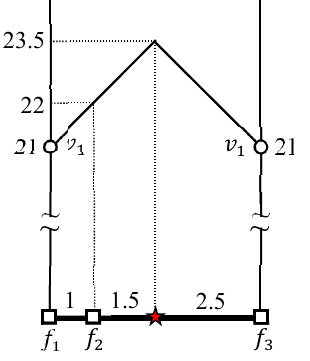
Figure 6. d max ( v 1 , f 1 f 2 f 3 ) = 23.5 and d min ( v 1 , f 1 f 2 f 3 ) = 21. Figure 6 depicts the computation of d max ( v 1 , f 1 f 2 f 3 ) . The distances from v 1 to end- points f 1 and f 3 of f 1 f 2 f 3 are d ( v 1 , f 1 ) = 21 and d ( v 1 , f 3 ) = 21, respectively, because